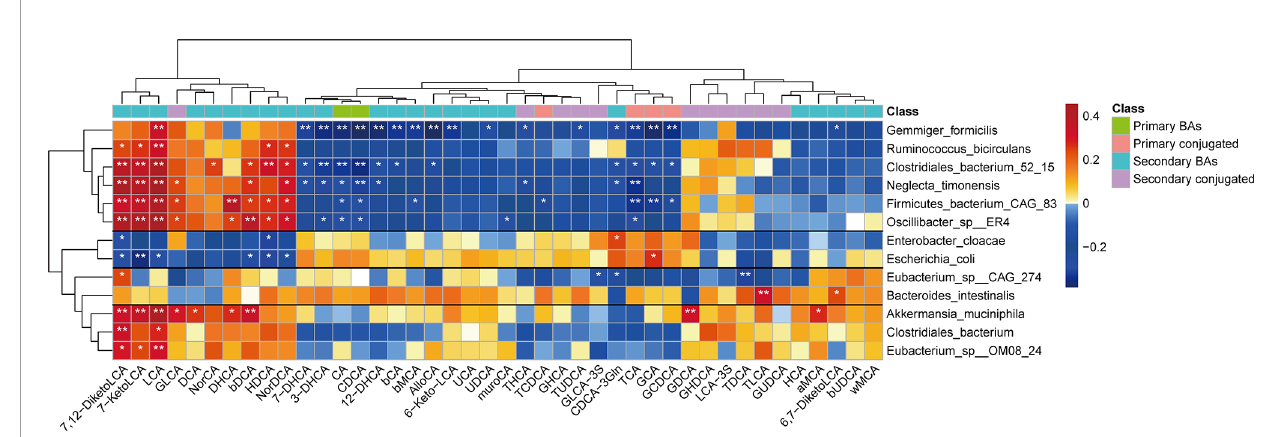
FIGURE 6 | Spearman ’ scorrelationanalysisoffecalbileacids andthetop13 bacterialtaxaatthe specieslevelwithsigni fi cantlydistinctrelativeabundancesbetweenthetwo groups.Four different groupsofbacteriataxa(groupsG1toG4)wereobserved. Blueandredrepresentthenegativeandpositivecorrelations,respectively.*P< 0.05;**P< 0.01. MCA,muricholicacid;LCA, lithocholicacid; GLCA, glycolithocholic acid; TLCA,taurolithocholicacid; GCDCA, glycochenodeoxycholicacid; TCDCA,taurochenodeoxycholicacid; TCA,taurocholicacid; GCA,glycocholic acid; TDCA,taurodeoxycholicacid; GDCA, glycodeoxycholicacid; TUDCA,tauroursodeoxycholic acid; GUDCA,glycoursodeoxycholic acid; GHCA, glycohyocholicacid; THCA, taurohyocholicacid; GHDCA,glycohyodeoxycholicacid;DHCA, dehydrocholicacid;HDCA, hyodeoxycholicacid; GLCA-3S, glycolithocholic